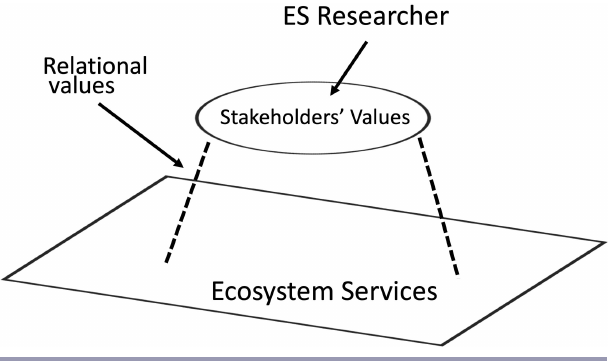
Fig. 5 . Conventional ecosystem services (ES) research assumes that values are superimposed on ES. Based on this schema the researcher stands above the world as she documents and compares different stakeholders’ values about